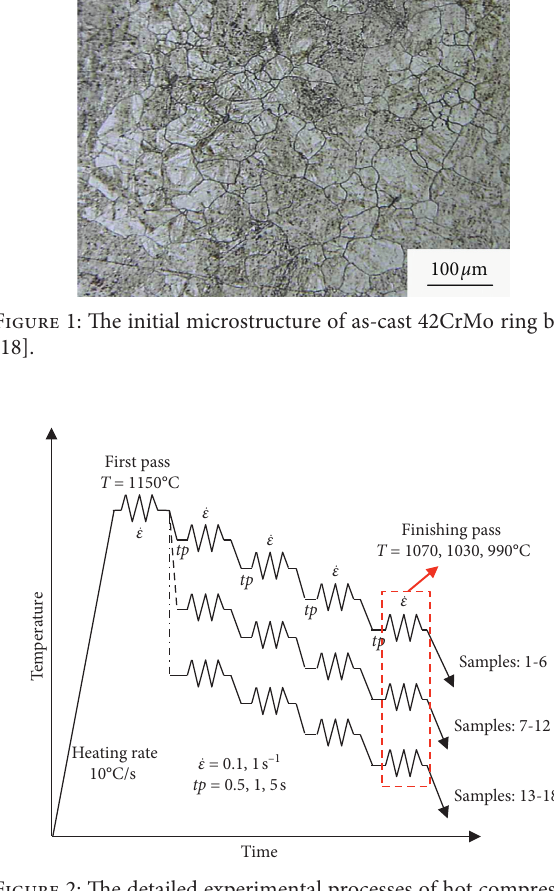
Figure 2: The detailed experimental processes of hot compression